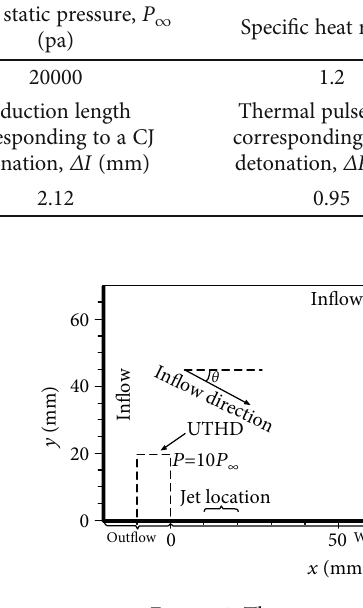
Figure 1: The computational